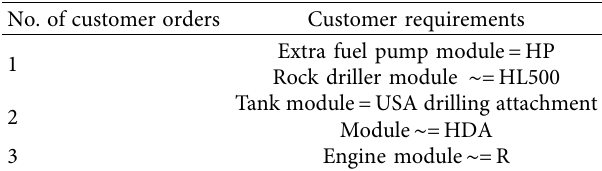
Table 3: Customer